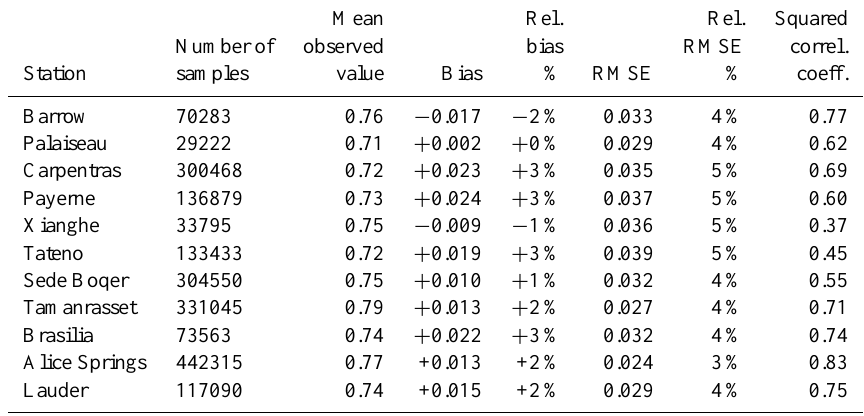
Table 4. Comparison between clear-sky global clearness indices measured by BSRN and estimated by McClear.